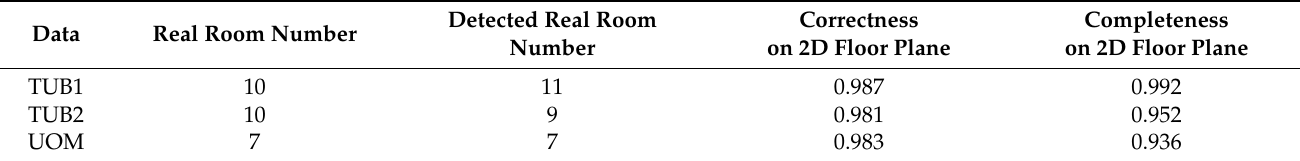
Table 4. Room reconstruction evaluation results of benchmark dataset.